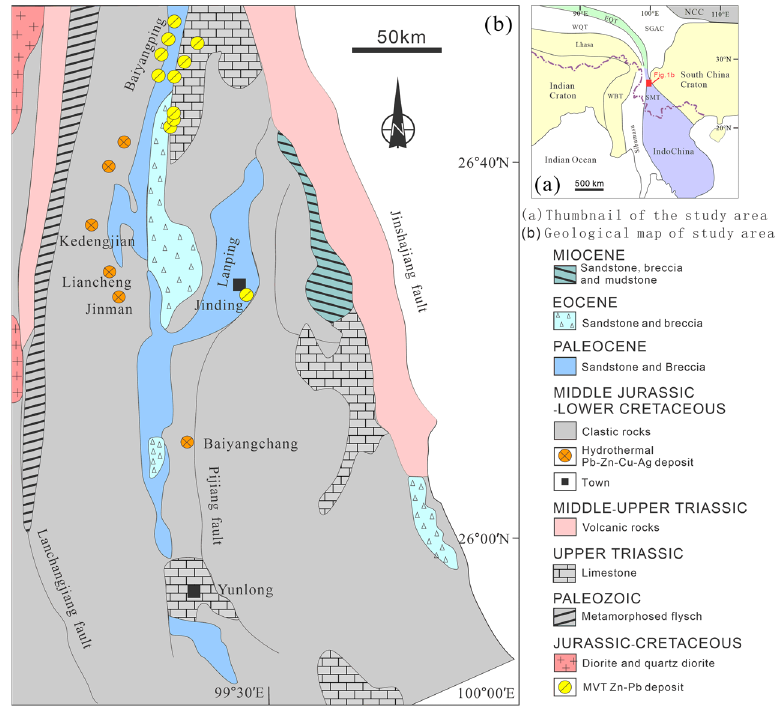
Figure 1. Geological map of the Jinman–Lanping area ( a,b ) [10].